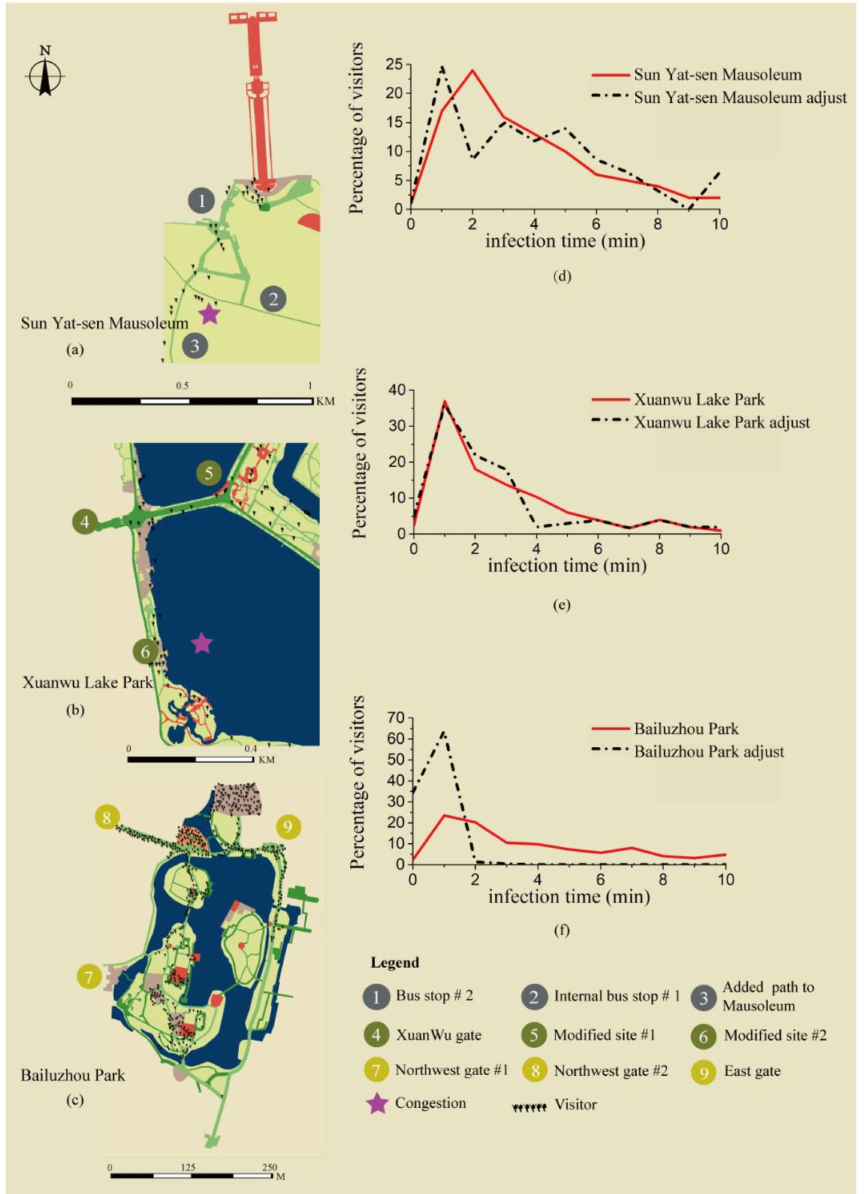
Figure 7. New congestion points in adjusted parks with changed contact periods of visitors. The tiny human shape figure in maps represents a single visitor. Purple stars display places of congestion. ( a ) is the visitor distribution map in adjusted Sun Yat-sen Mausoleum, which has a new congestion; ( d ) is the comparison between visitor infection time before and after park adjustment; ( b ) is the visitor distribution map in adjusted Xuanwu Lake Park, which has one congestion; ( e ) is the comparison between visitor infection time before and after park adjustment; ( c ) is the visitor distribution map in adjusted Bailuzhou Park, which has no congestion; ( f ) is the comparison between visitor infection time before and after park adjustment. Copyright 2020 © Author, all rights reserved, used by